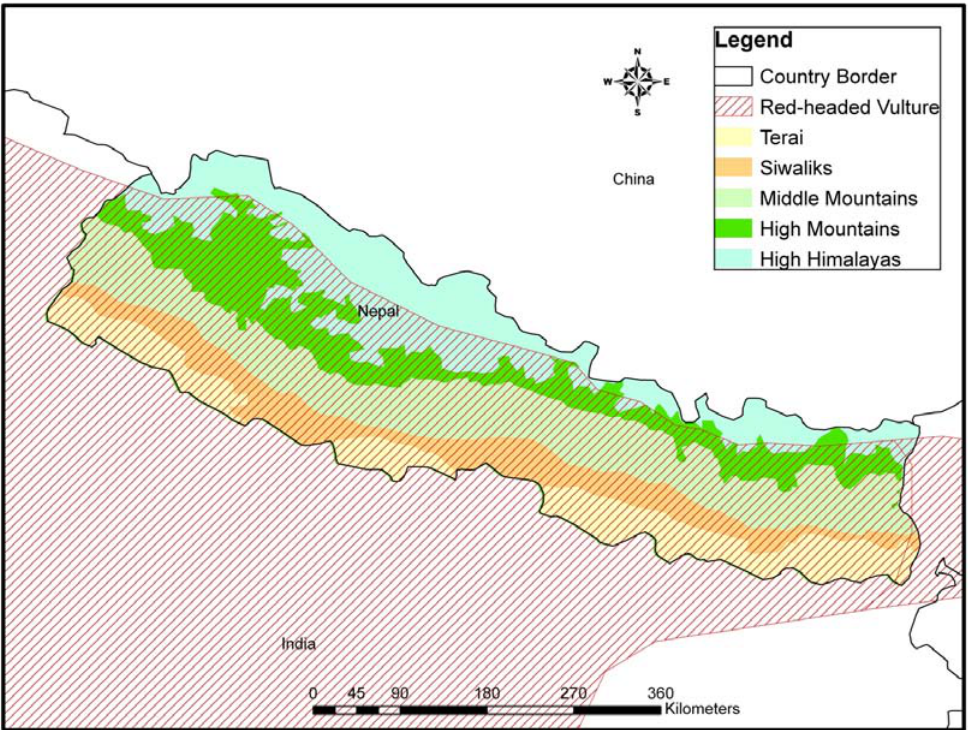
Figure 7. Red-headed Vulture distribution in Nepal. Adapted from (Birdlife International & NatureServe